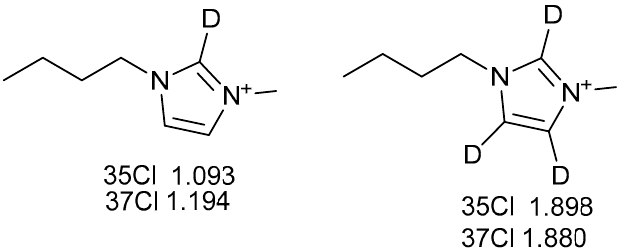
Figure 3. Numbers are deuterium isotope effects observed at the Cl resonance caused by the deu- terium. Uncertainties ~0.1 ppm. Data from Ref. [14].